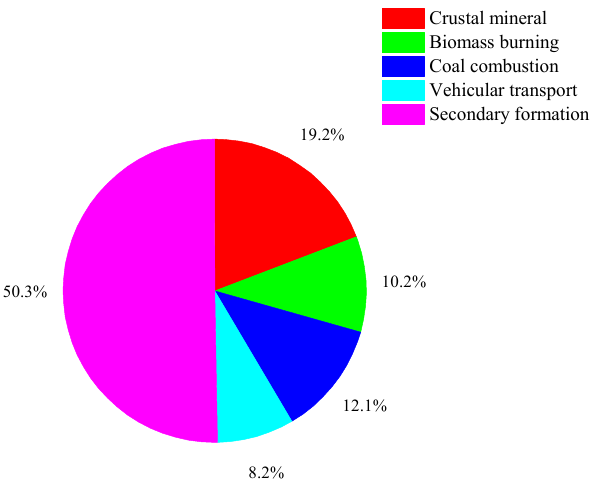
Figure 12. Distribution of different sources.